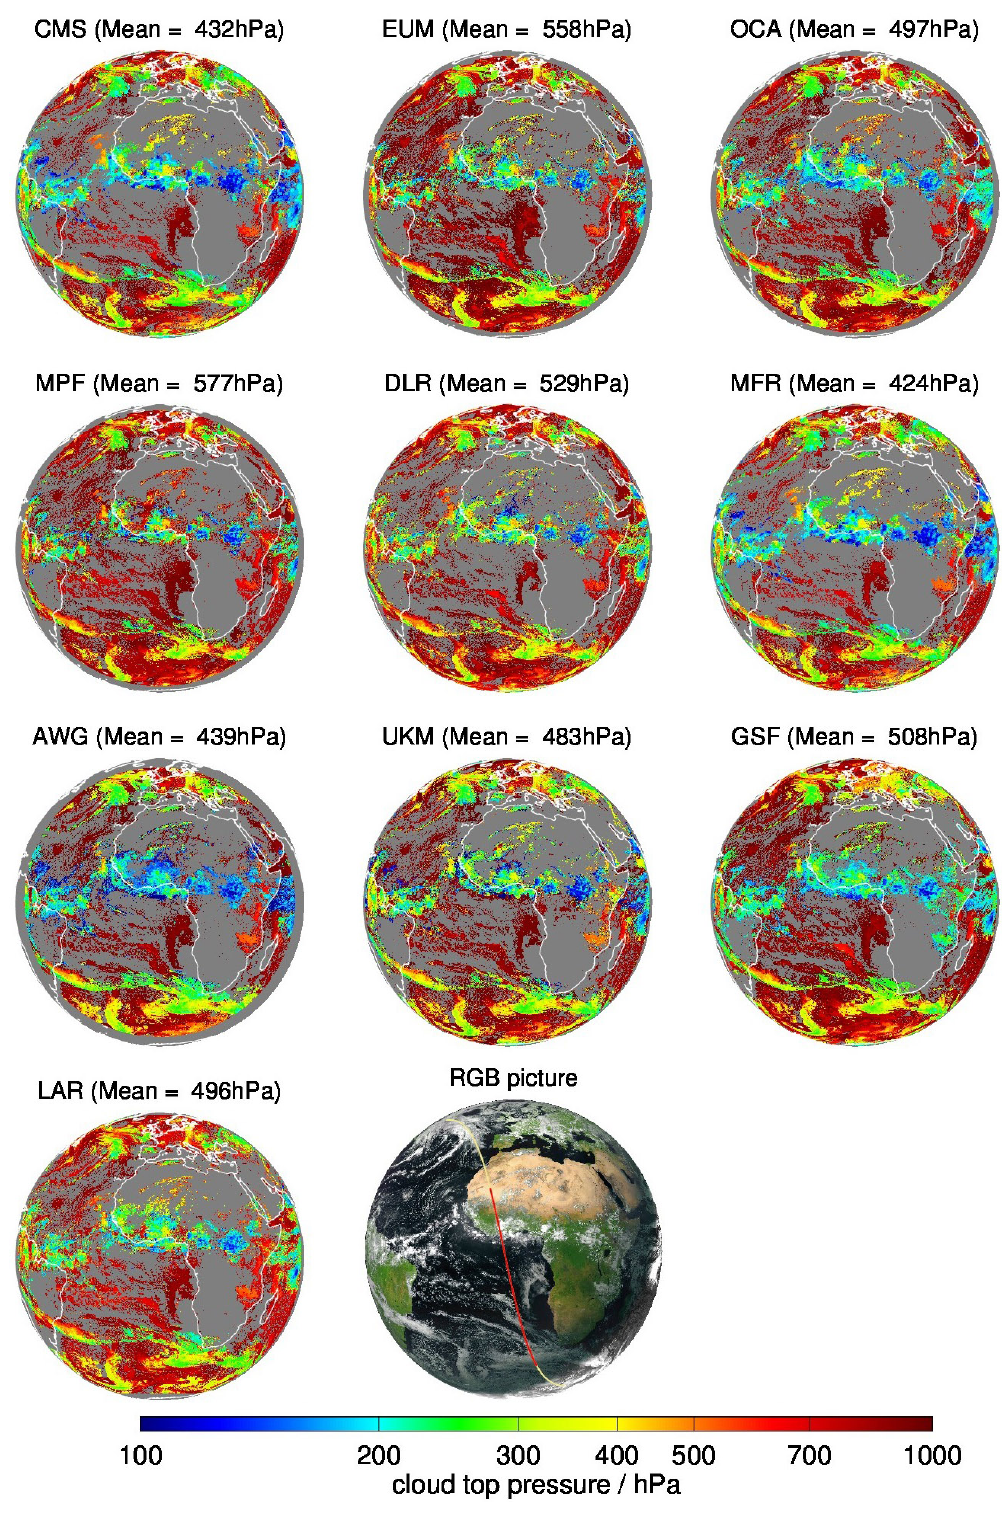
Figure 1. Cloud top pressure (CTP) of ten SEVIRI algorithms for the 13 June 2008, 13:45UTC. The mean CTP is calculated by averaging the logarithm of the CTP. The last plot shows the corresponding RGB image of the scene. The track of the A-train satellite constellation between 13:45UTC and 14:00UTC is indicated as a red